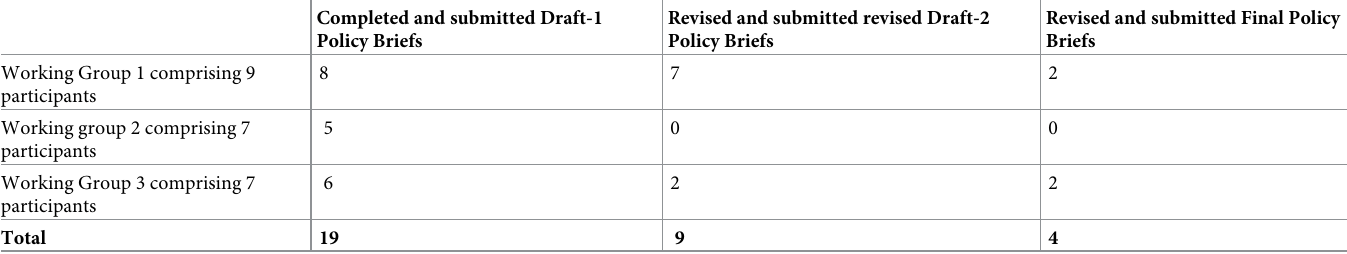
Table 8. Policy brief writing and completion